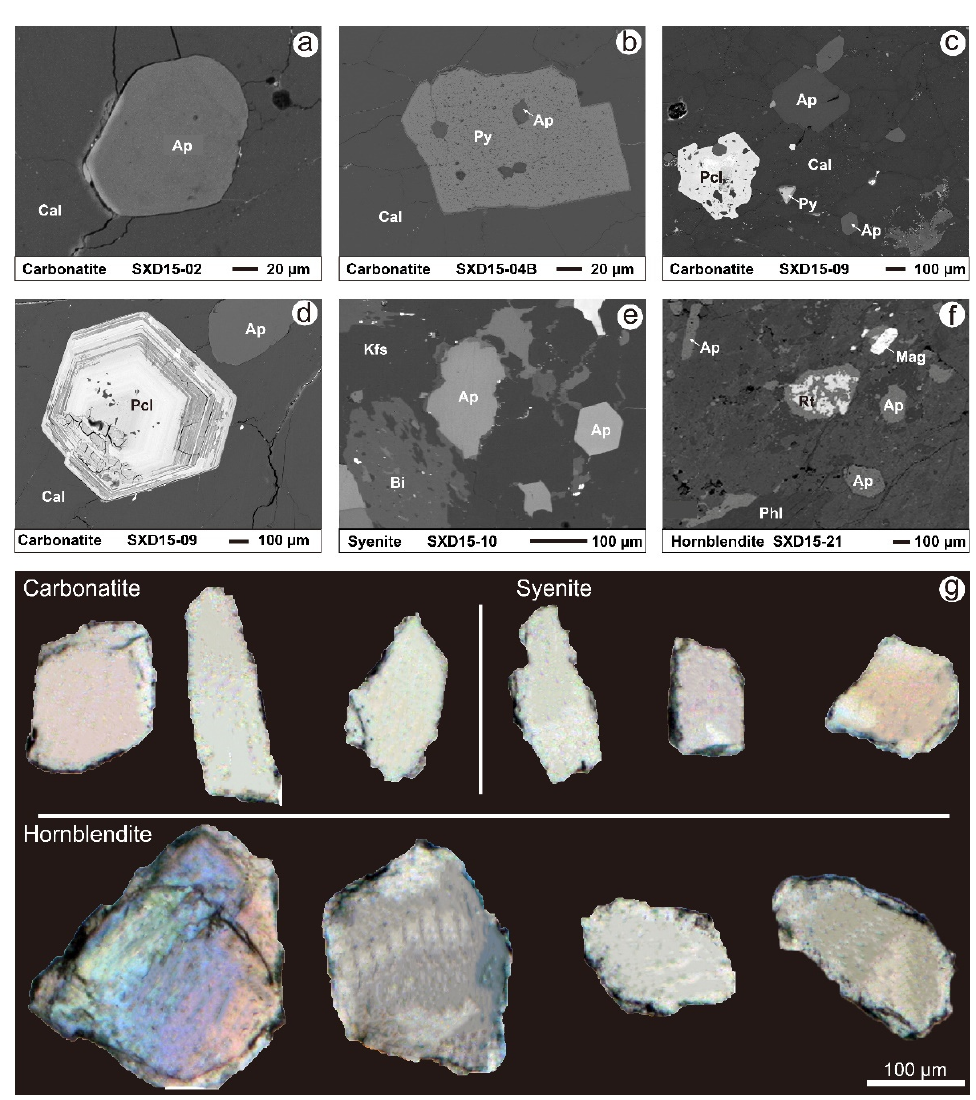
Figure 2. BSE of the SXD carbonatite ( a – d ), syenite ( e ), and hornblendite ( f ); and photomicrographs in transmitted light of representative apatite from the SXD complex ( g ). Symbols: Ap—apatite; Cal—calcite; Py—pyrite; Pcl—pyrochlore; Kfs—alkali feldspar; Bi—biotite; Mag—magnetite; Hbl—hornblende; Rt—rutile; Phl—phlogopite.